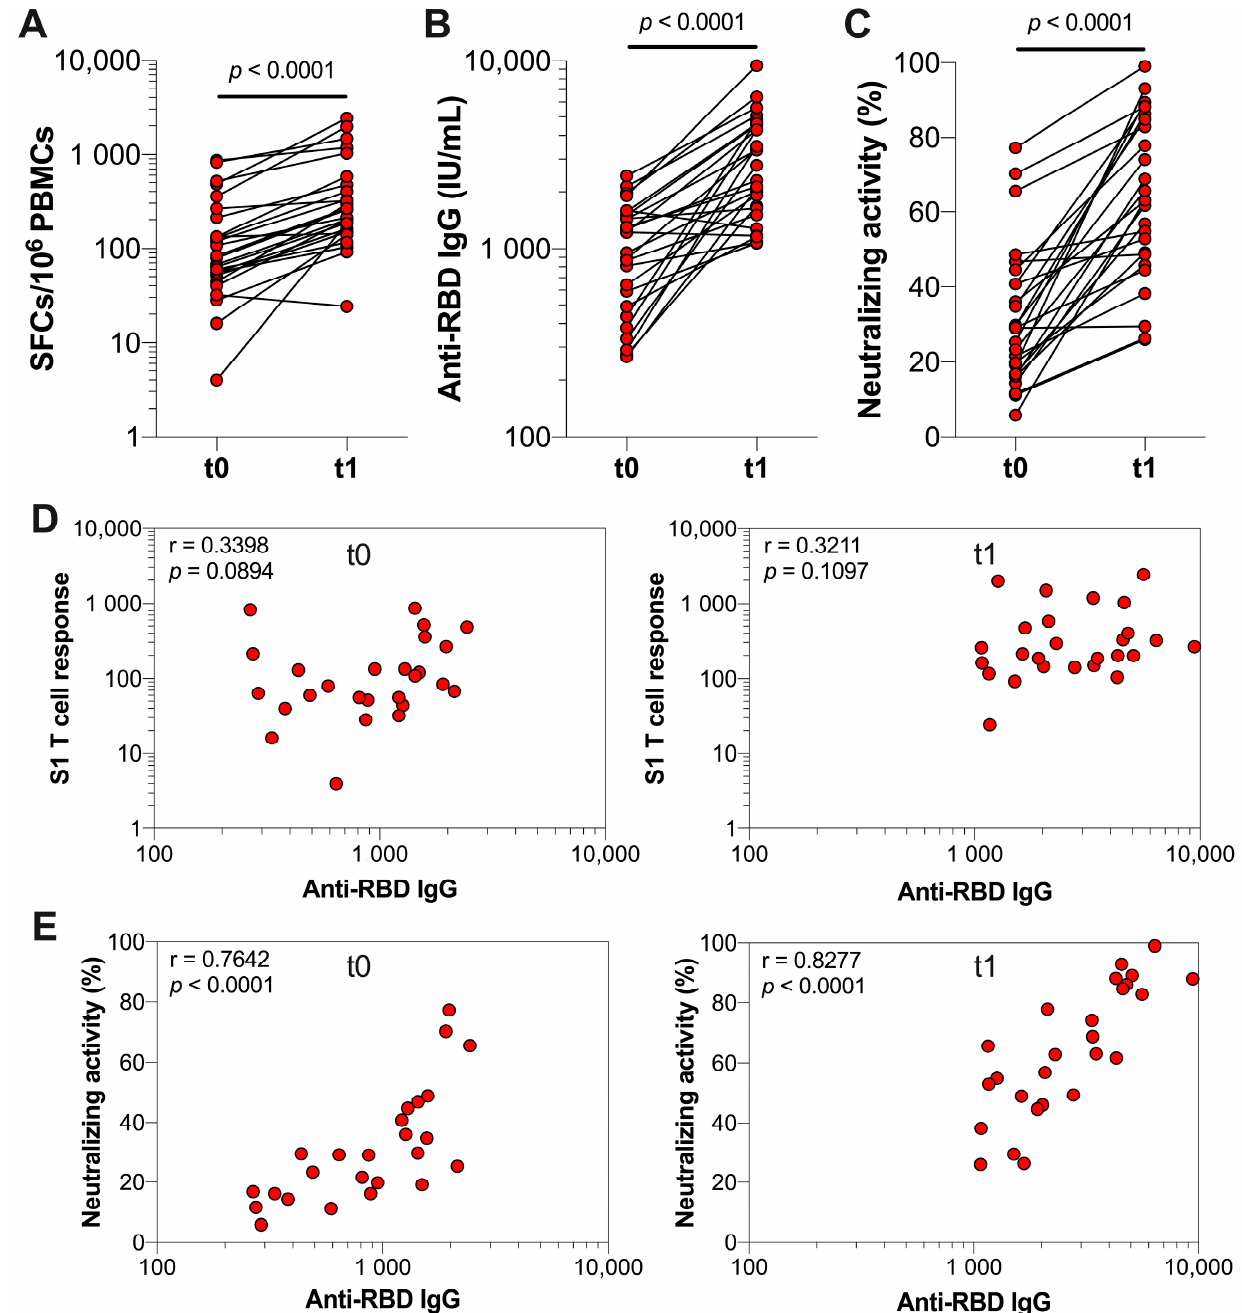
Figure 3. SARS-CoV-2-specific T cell and antibody responses of previously infected HCWs before and after booster vaccination. Immune responses of previously infected HCWs ( n = 26) were assessed at median 1 (IQR 1–7) day before (t0) and 27 (IQR 24–29) days after (t1) receiving the BNT162b2 or mRNA-1273 booster vaccination. Each data point represents an individual HCW. ( A ) T cell responses against SARS-CoV-2 S1 and N. ( B ) Serum anti-RBD IgG concentrations. ( C ) Neutralizing activity of serum antibodies against SARS-CoV-2. ( D ) Association between SARS-CoV-2 S1-specific T cell responses and anti-RBD IgG concentrations at t0 and t1. ( E ) Association between the neutralizing activities and anti-RBD IgG concentrations at t0 and t1. Statistical significance between paired data was assessed with a Wilcoxon test ( A – C ) and associations were assessed by Spearman’s rank correlation ( D , E ).